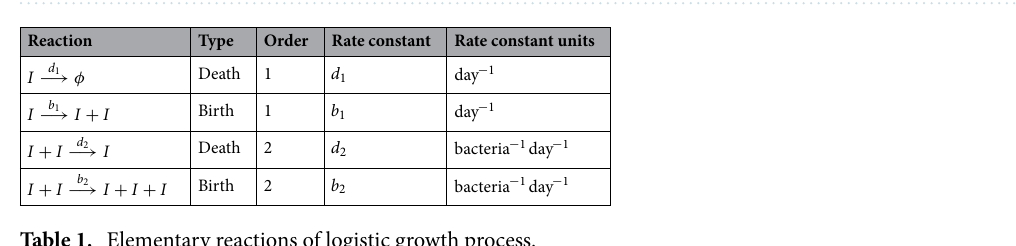
Table 1. Elementary reactions of logistic growth